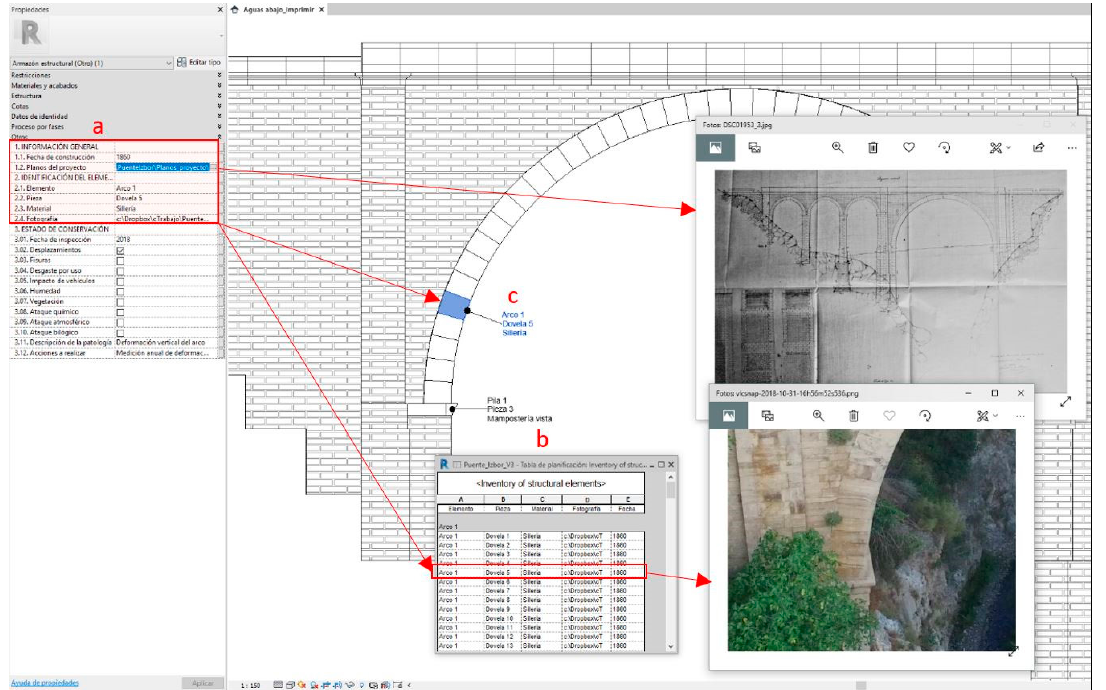
Figure 10. Identification and labeling of elements.